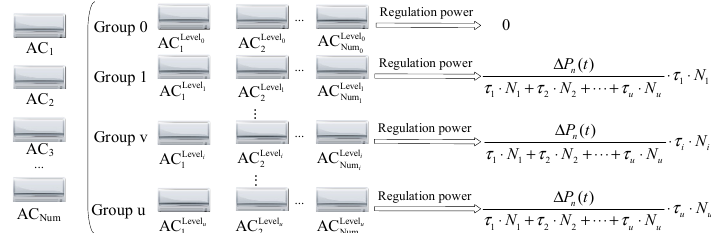
Figure 3. The classification process of the ACs.